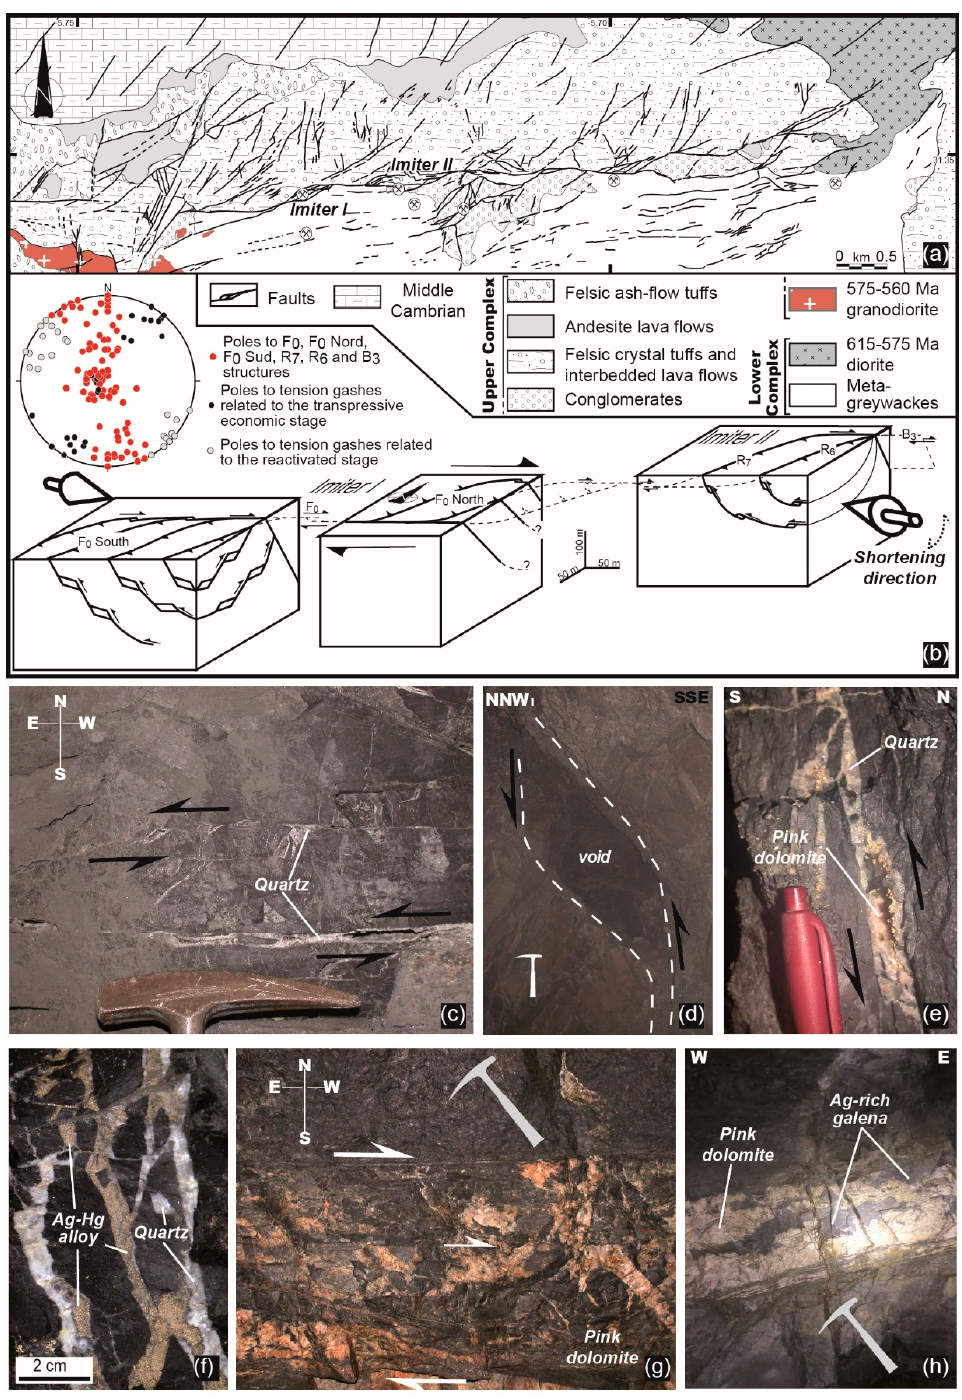
Figure 11. Main features of the world-class Ag–Hg Imiter mining district [47,102]. ( a ) General map of the giant Ag–Hg Imiter mine (after Leistel and Qadrouci [127] and Tuduri [47]) and ( b ) stereoplots of structural orientations and interpretative block diagram explaining the formation of the main ore-bearing vein system. Thrusts are formed in core of transpressive push-up structures. Note that the mineralised structures were everywhere controlled by a ESE–WNW direction of shortening. ( c ) Pull-apart and tension-gashes structures of the economic stage filled by geodic quartz and